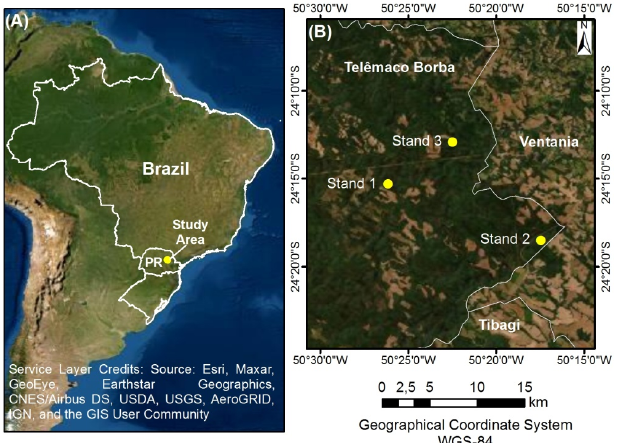
Figure 1. Location of the study area in Brazil, in the state of Paraná (A) and in Telêmaco Borba municipality (B).